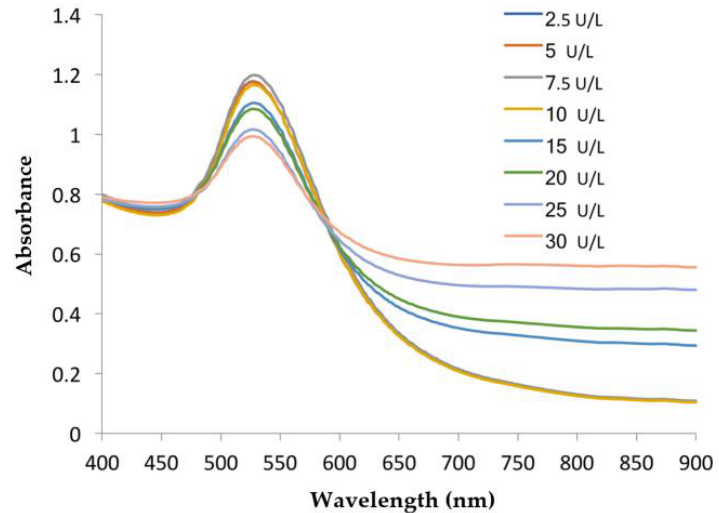
Figure 4. UV-visible absorption spectra of C/G-capped Au NPs after incubation with different activities of DPP-IV/CD26. The DPP-IV/CD26 activity ranged from 10 to 30 U/L. Lower DPP-IV/CD26 activities did not induce spectral changes.